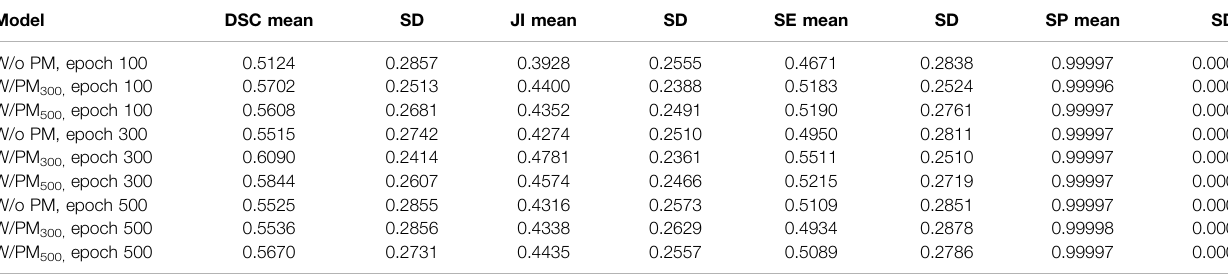
TABLE 4 | egmentation metrics of test set using Decathlon small .